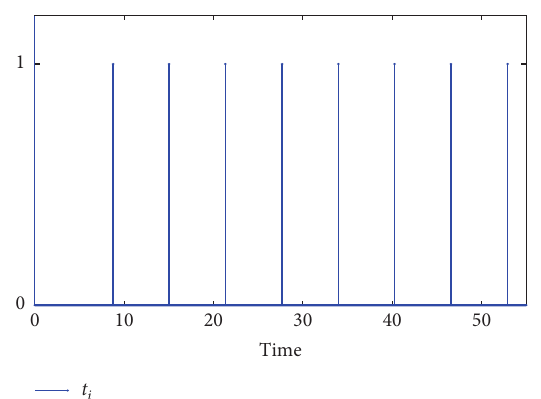
Figure 12: The starting instant of each control of the observer- based